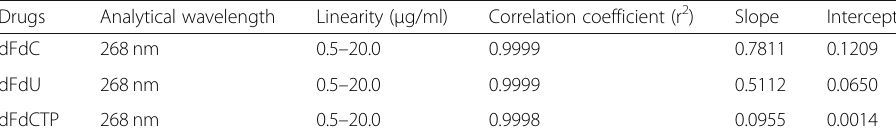
Table 2 Linear regression parameters of calibration equations for the standards Drugs Analytical wavelength Linearity ( μ g/ml)